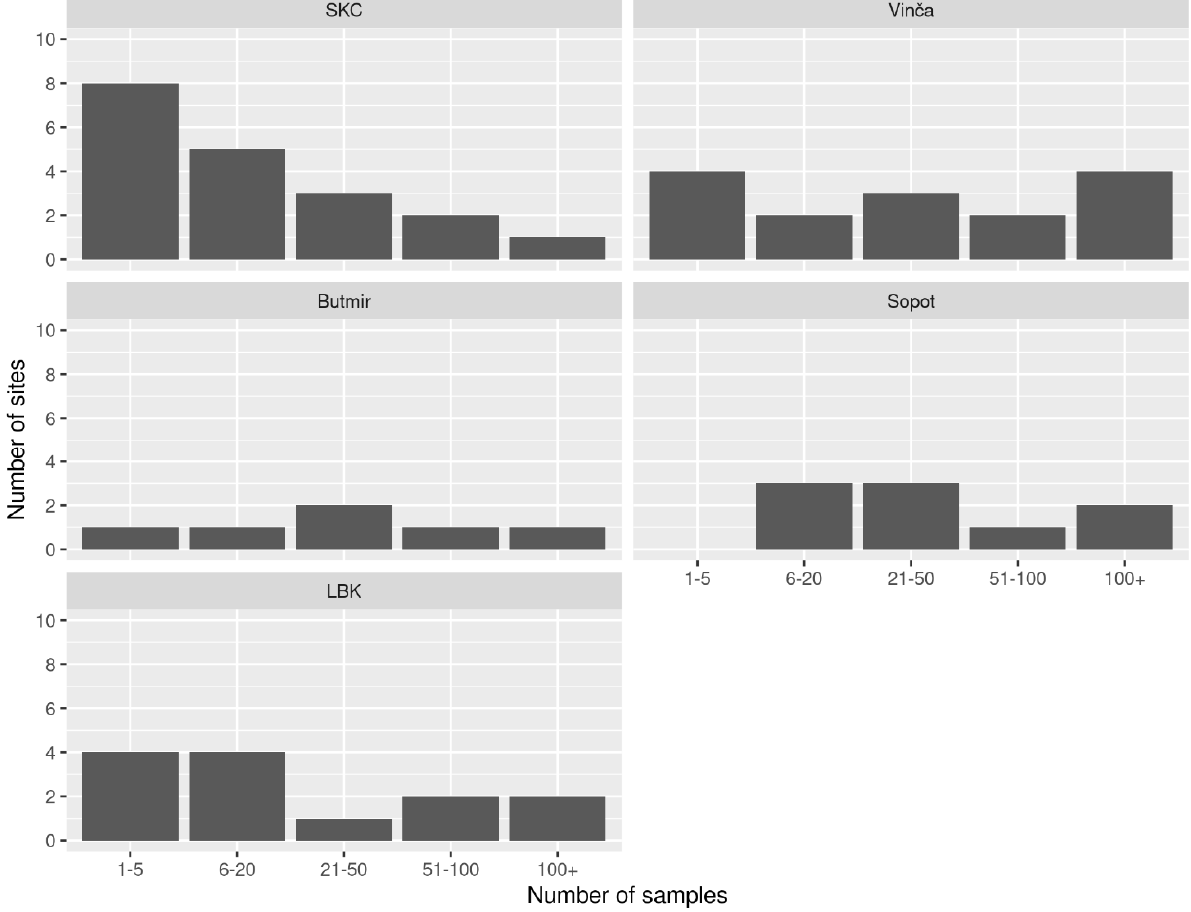
Figure 4. Sampling intensity by archaeological culture.